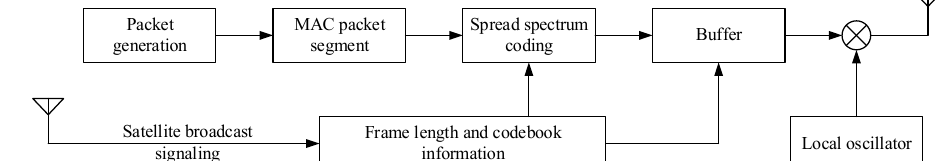
Figure 8. On ‐ board load architecture design.